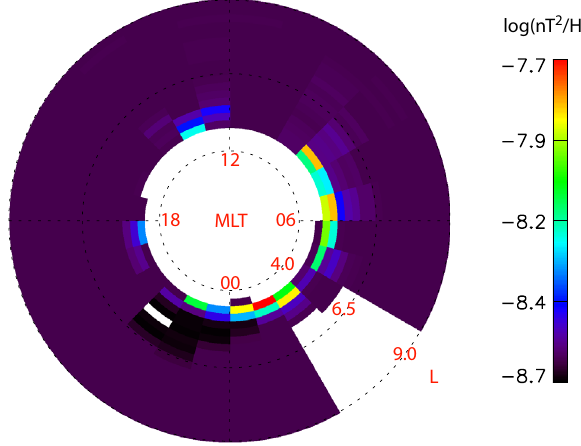
Fig. 4. Distribution of the spectral density in the frequency range 0 . 5 ≤ f/f ce < 1 dominated by upper-band